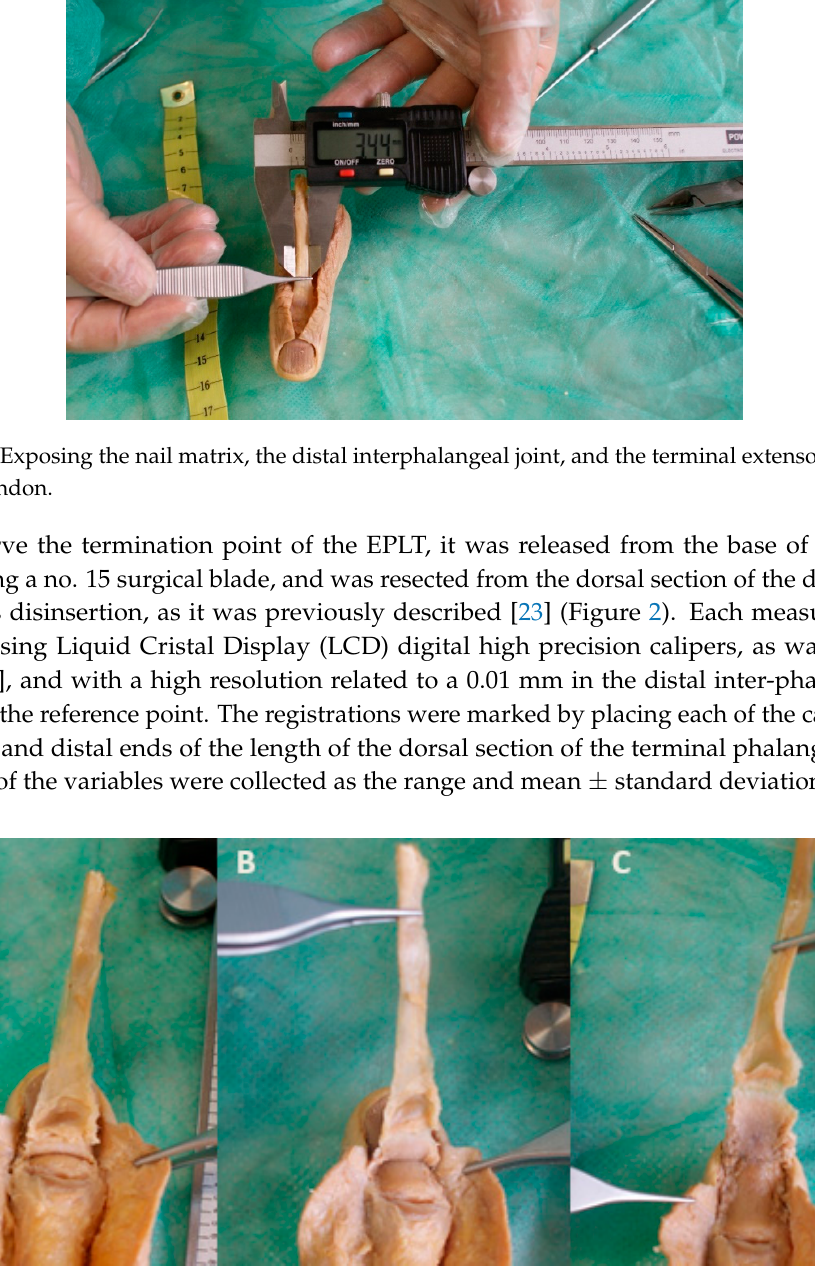
Figure 2. Exposing the distal insertion of the extensor pollicis longus tendon at the base of distal phalanx to the point of the proximal nail matrix fold. ( A ) The tendon attached to the dorsal aspect of the base of the distal phalanx from the distal interphalangeal joint line to the tendon reaching the proximal nail fold matrix. ( B ) The tendon at the middle aspect of the distal phalanx in the same specimen. ( C ) The tendon reaching the distal aspect of the distal phalanx.